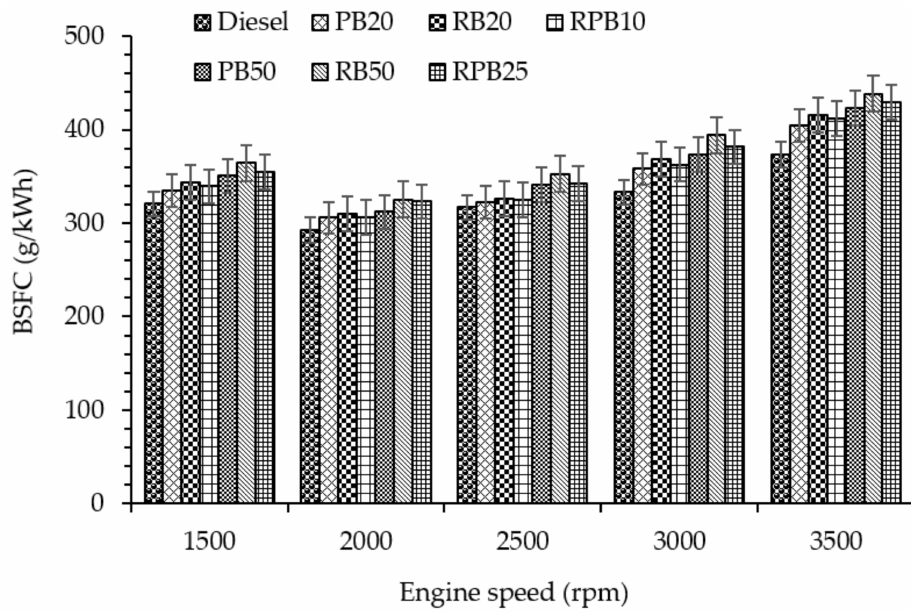
Figure 3. Variation of the BSFC with respect to engine